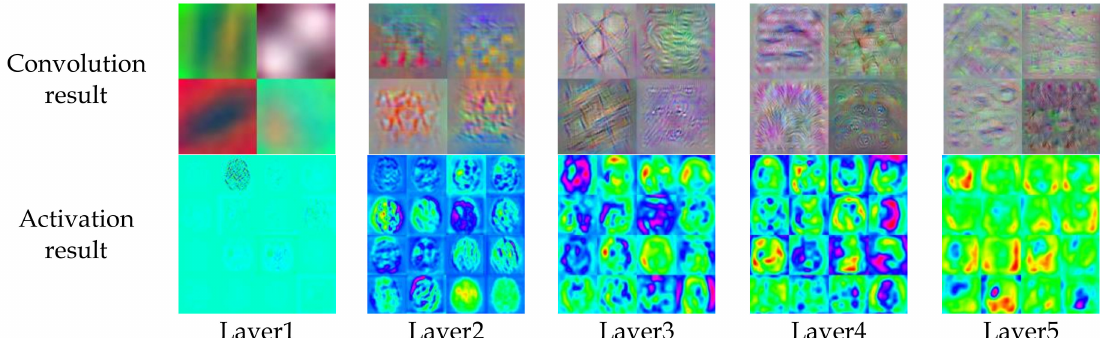
Figure 4. Sample outcome attained with customized VGG19.